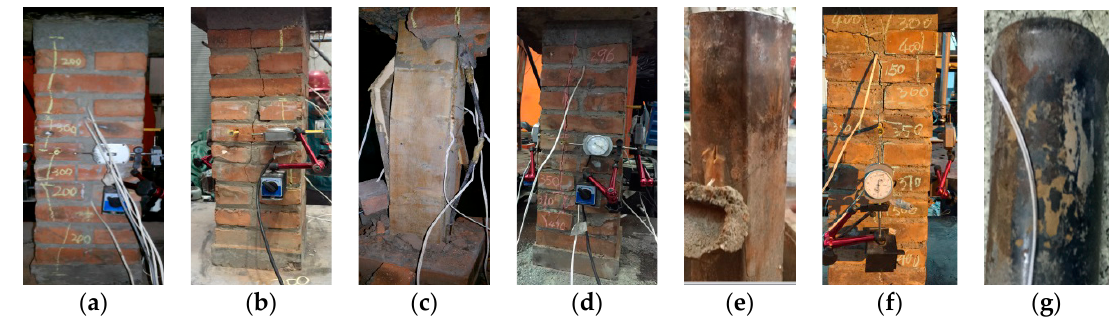
Figure 5. Failure states of FCB1 ‐ FCB4: ( a ) FCB1; ( b ) FCB2; ( c ) square ‐ shaped wood; ( d ) FCB3; ( e ) square ‐ shaped steel pine; ( f ) FCB4; and ( g ) circular steel pine.